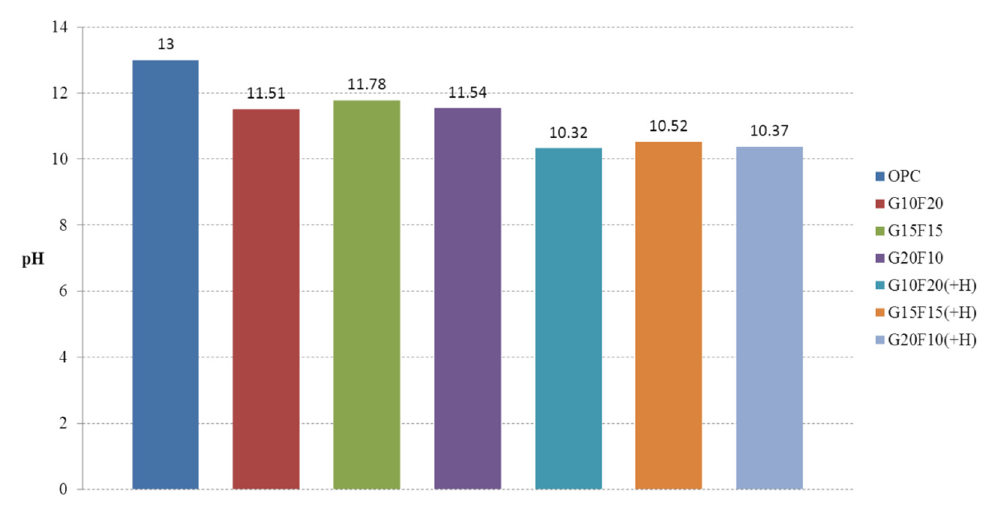
Figure 6. pH test results (W/B 45%).